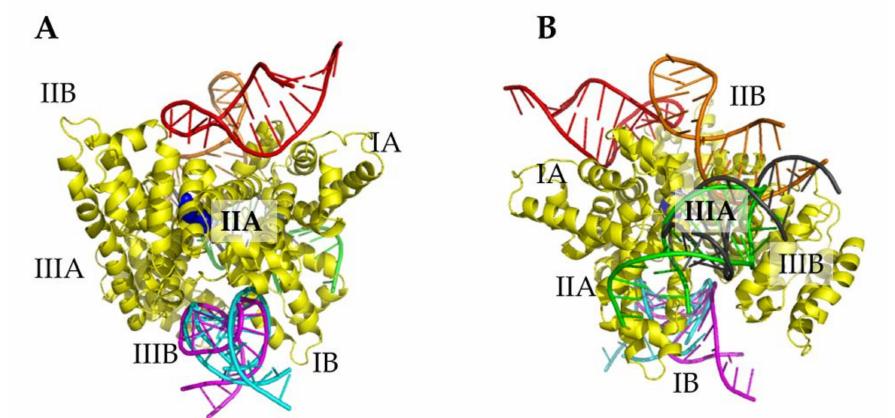
Figure 4. Collective representation of the six best models for HSA/miR4749 complex ( A ) at the front and ( B ) at the back. HSA is coloured in yellow, while miR4749 is coloured as follows: Model 1 (green), Model 2 (orange), Model 3 (magenta), Model 4 (red), Model 5 (gray) and Model 6 (cyan). The regions of HSA are labelled and Trp214 atoms are shown as blue spheres.